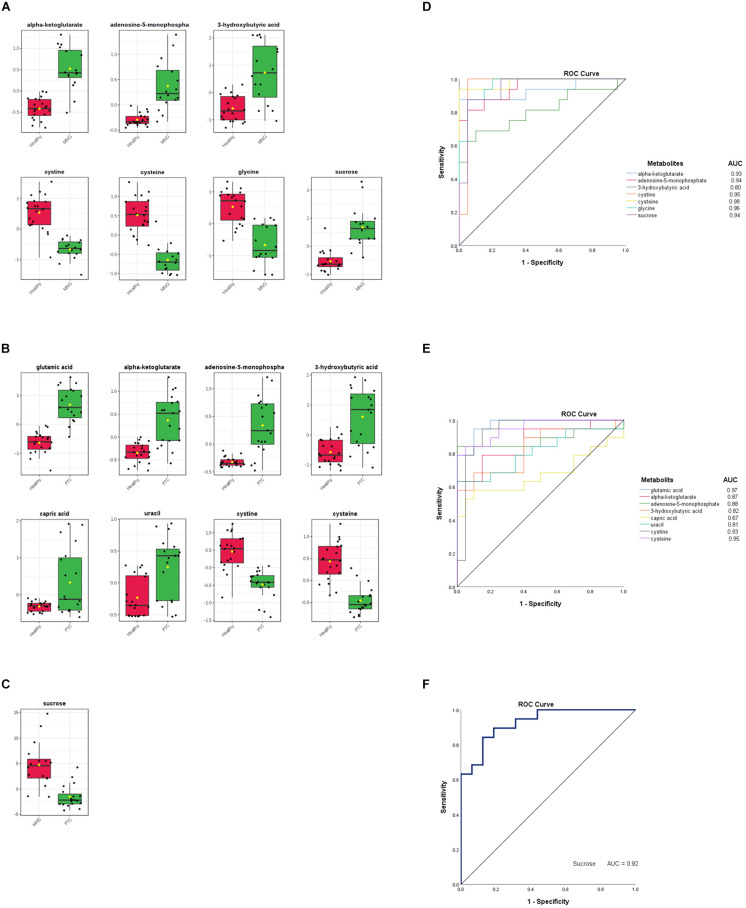
(A–C) Box plots visualize each significantly altered metabolite between two groups separately, which were all predicted with the volcano plots. The x-axis shows the specific metabolite and the y-axis is the normalized peak intensity. ROC curve analyses of the ability of seven metabolites to predict MNG vs healthy (D), eight metabolites to predict PTC vs healthy (E), and one metabolite included sucrose to predict MNG vs PTC (F) which were all identified with the volcano plots. ROC; Receiver operating characteristic, PTC; papillary thyroid carcinoma, MNG; multinodular goiter.